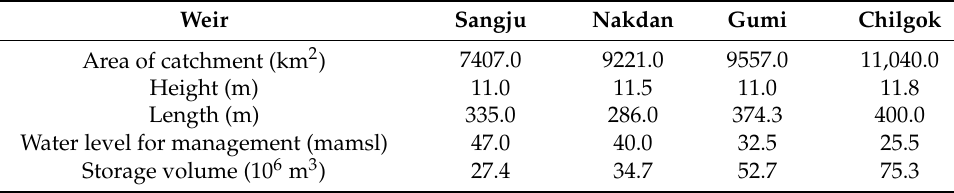
Table 2. Details about Sangju, Nakdan, Gumi, and Chilgok weirs.